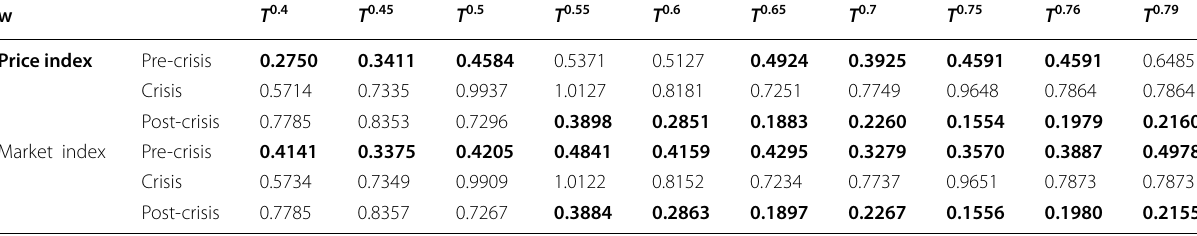
Table 10 Semiparametric estimates of d for the pre- and post-crisis periods (volatility series)